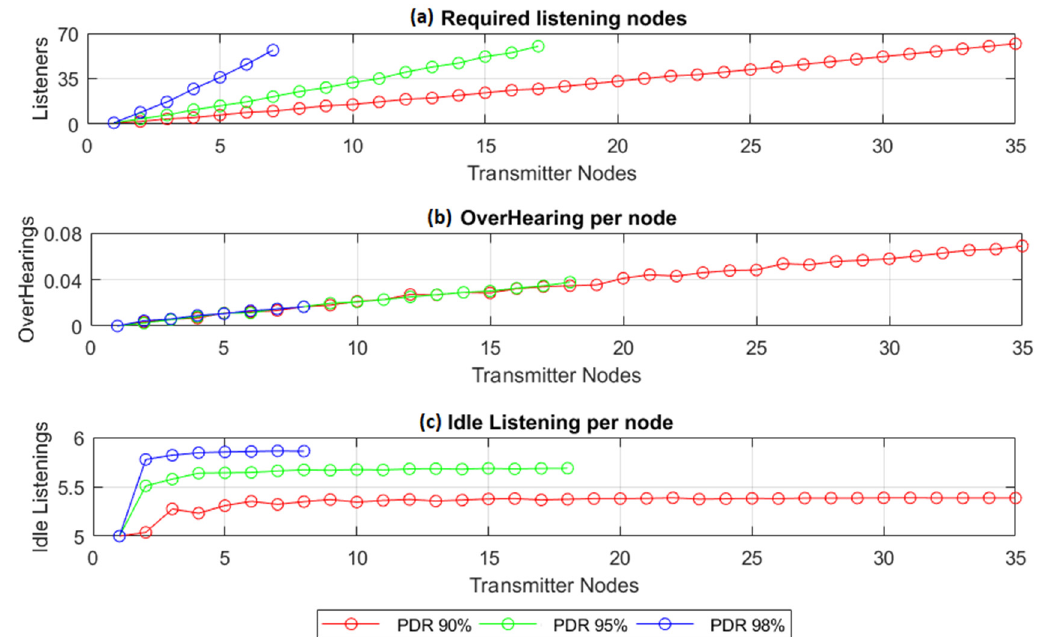
Figure 15. Average performance per number of transmitter nodes in terms of: ( a ) required listening nodes, ( b ) overhearing nodes, ( c ) idle listening per node. The experiment was performed for 50-byte application data using six listening windows in a multi-frame structure of eleven frames of twenty cells each.